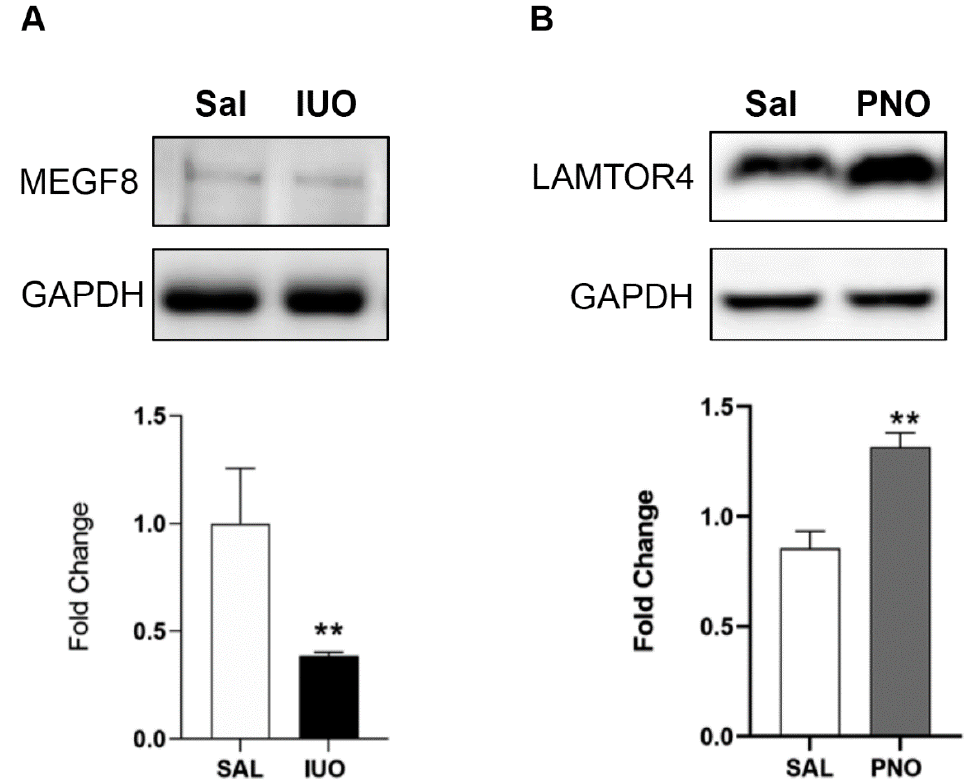
Figure 6. Validation of regulation of MEGF8 and LAMTOR4. Representative Western blot analysis on SV markers isolated from PNO, IUO, and saline shows the downregulation of MEGF8 in the IUO group ( A ) and upregulation of LAMTOR4 in the PNO group ( B ). Data represented as mean ± SEM, n = 5–6 animals per group, ** p < 0.01 as determined by an unpaired t -test after Welch’s correction.